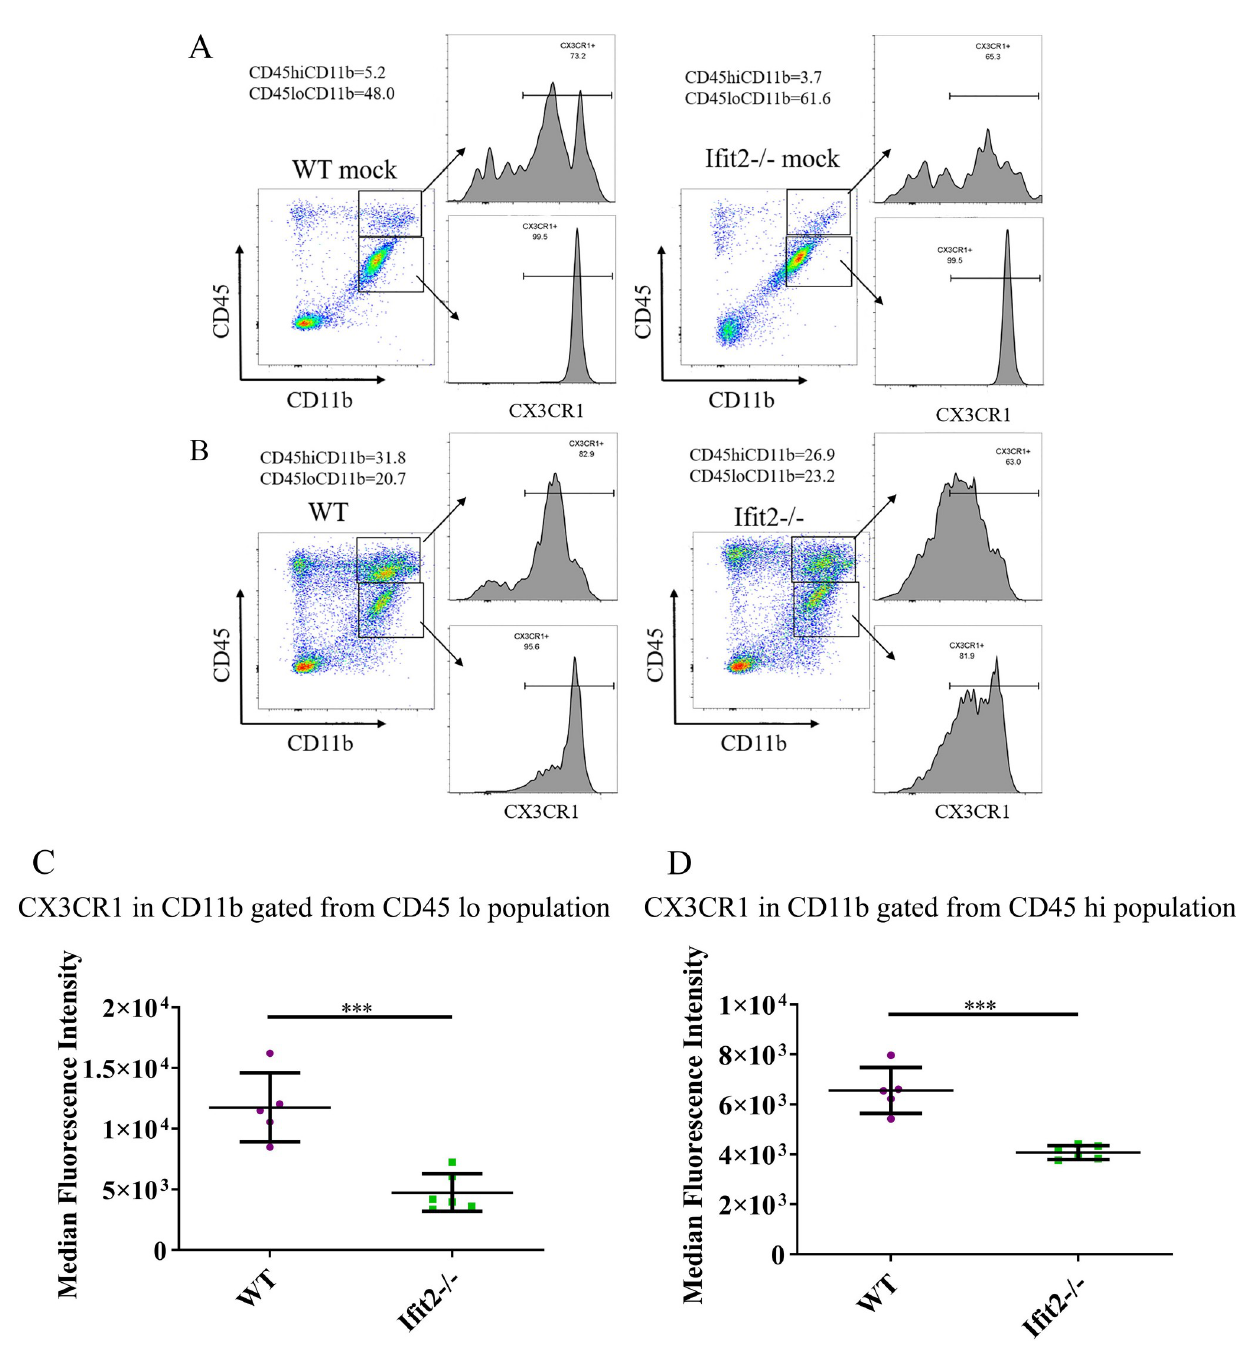
Fig 10. Ifit2 deficiency decreases CX3CR1 expression in microglia following infection. Brain derived cells from WT and Ifit2 -/- mice either mock infected (Panel A) or infected with RSA59 (Panel B) were stained for CD45, CD11b and CX3CR1 expression at 5 days p.i. Dot plots show gating and percentages of CD45 hi CD11b + and CD45 lo CD11b + populations as indicated. Histograms show CX3CR1 expression on the respective gated myeloid cell populations as indicated by arrows. Panels C and D show Median Fluorescent Intensity of CX3CR1 expression by CD45 lo CD11b + microglia and CD45 hi CD11b + infiltrates of WT (Purple) and Ifit2 -/- (Green) mice, respectively.The experiment is repeated 2–3 times with n = 5–6. Asterix ( � ) represents differences that are statistically significant by Student’s unpaired t-test analysis. ( ��� P < 0.001).